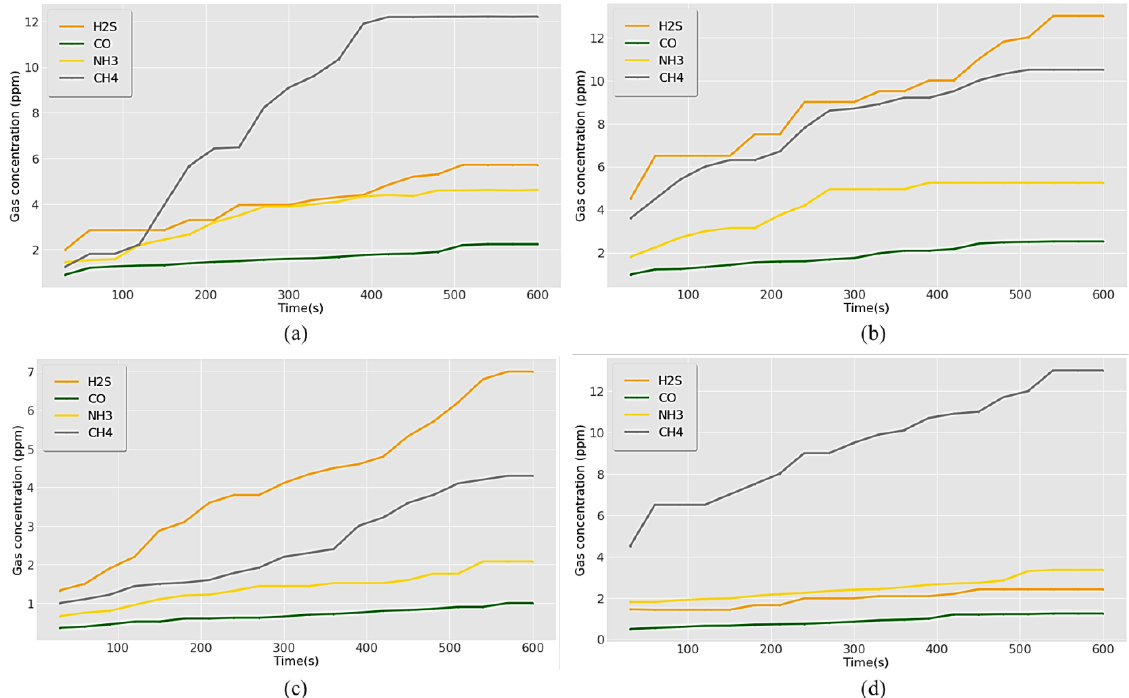
Figure 12. Recorded results for concentration of toxic gases in ( a ) landfill area, ( b ) primary sedimen- tation tank, ( c ) secondary clarifier, and ( d ) sludge digestion